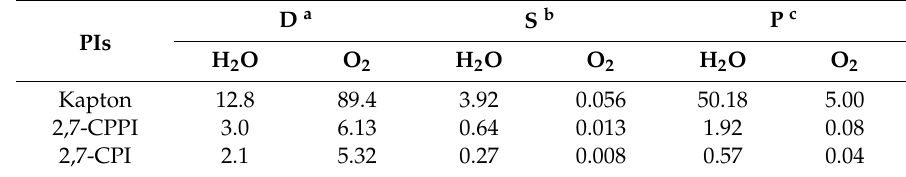
Figure 13. log(MSD) of O 2 and H 2 O in Kapton, 2,7-CPPI and 2,7-CPI as a function of time. Table 4. Simulated diffusion coefficients, solubility coefficients, and permeability for O 2 and H 2 O in Kapton, 2,7 ‐ CPPI and 2,7 ‐ CPI.